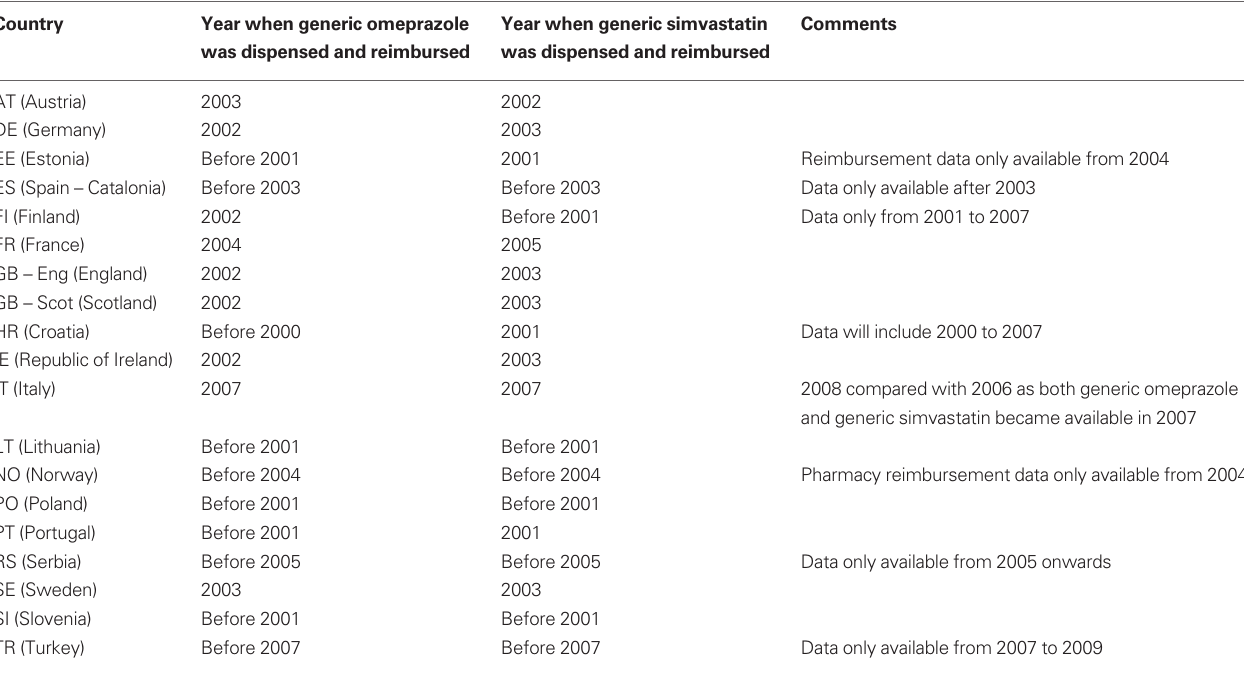
Table 2 | Dates when generic omeprazole and generic simvastatin were first dispensed and reimbursed among European